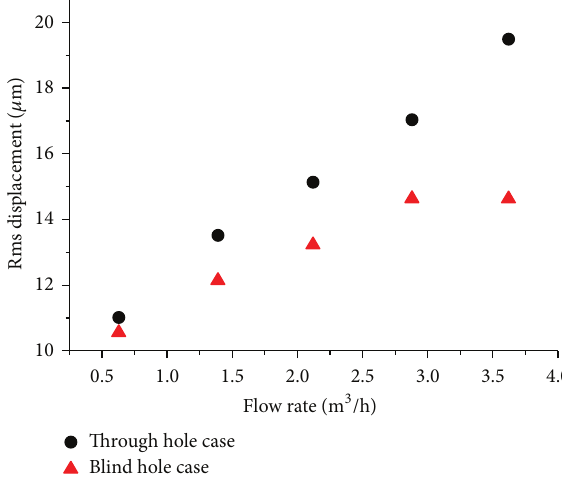
Figure 15: Probability density distributions of displacements in through hole case at 𝑞 V = 3.62 m 3 / h.